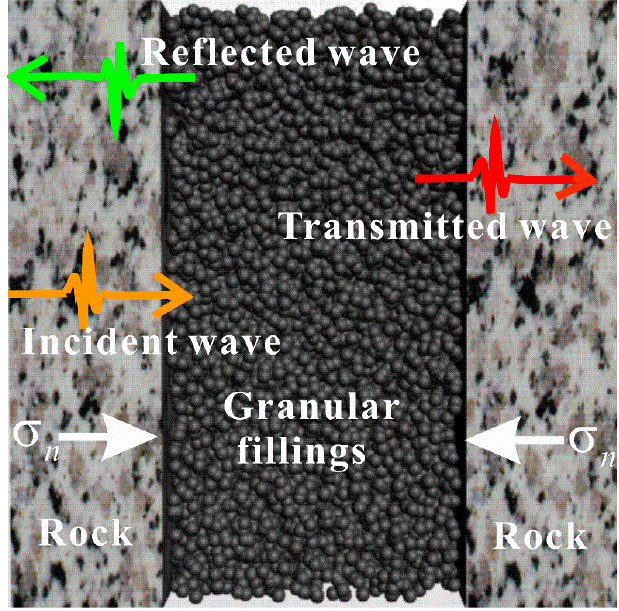
Figure 1. Schematic view of a filled joint loaded by stress waves (adapted from [23]).